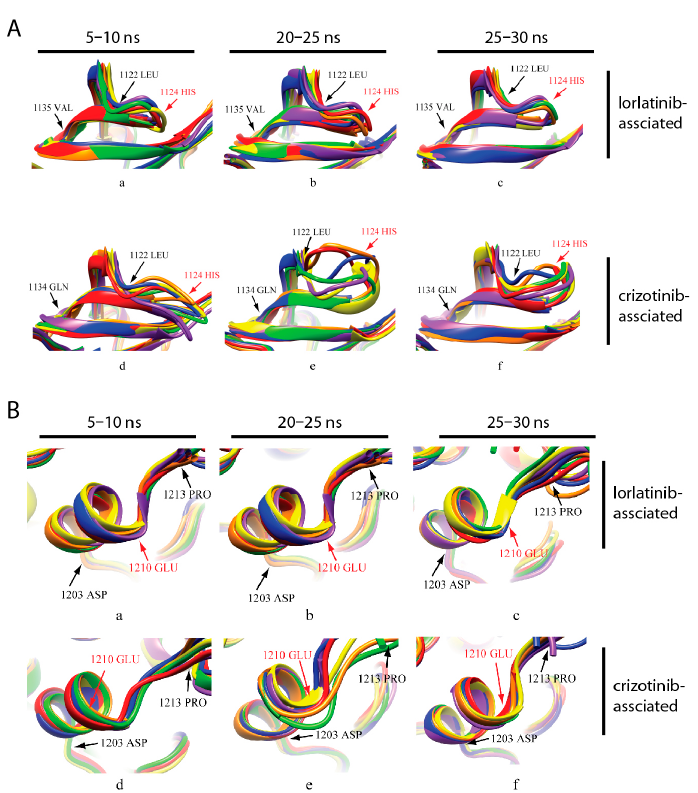
Figure 10. Secondary structure comparison of domains around His1124 and Glu1210. Protein Data Bank (PDB) structures of the inhibitor associated to ALK—lorlatinib-associated (PDB ID: 5AA8; a – c ) and crizotinib-associated (PDB ID: 5AAB; d – f )—from different time points were extracted and superimposed to analyze the secondary structure change of the domains of around His1124 ( A ) and Glu1210 ( B ). Structures from six different time points combined and color coded (5–10 ns: 5 ns red, 6 ns orange, 7 ns yellow, 8 ns green, 9 ns blue, 10 ns purple; 20–25 ns: 20 ns red, 21 ns orange, 22 ns yellow, 23 ns green, 24 ns blue, 25 ns purple; 25–30 ns: 25 ns red, 26 ns orange, 27 ns yellow, 28 ns green, 29 ns blue, 30 ns purple).